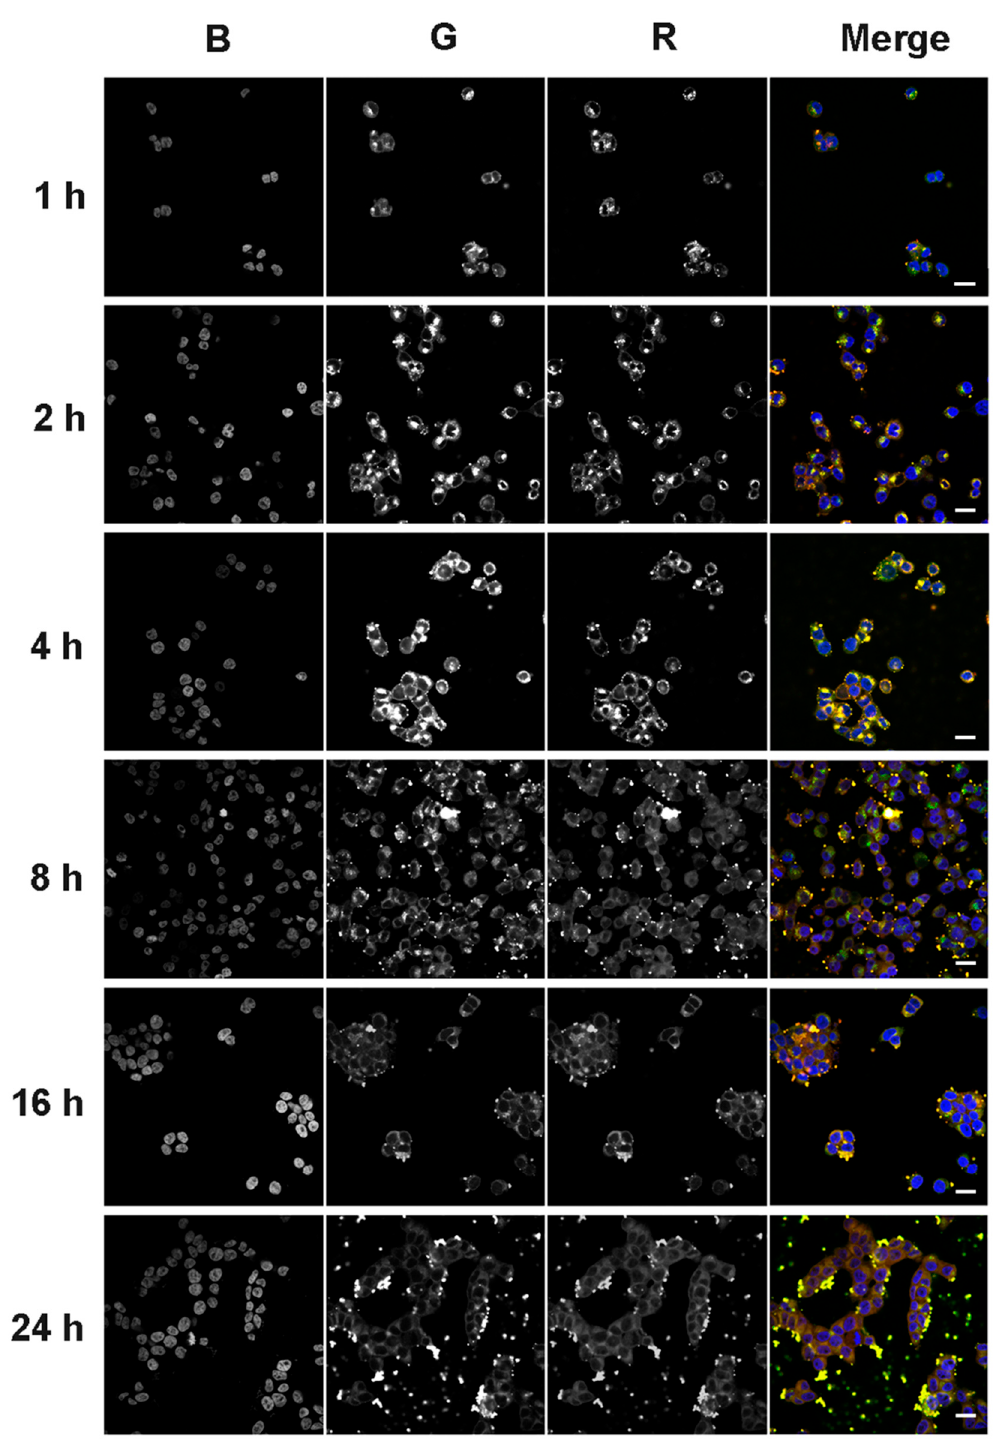
Figure 8. Accumulation of duplexes TD3 / ON-PO in KB-8-5 cells. Analysis of samples was performed 1, 2, 4, 8, 16 and 24 h after addition of duplexes (1 µ M) to the cells. Duplexes consisted of FAM-labeled TD3 and By5.5-labeled ON-PO. Analysis was performed with confocal fluorescent microscopy by using a plan-apochromat 63 × / 1.40 Oil DIC M27 objective. Three-channel (BGR) pictures were obtained using staining by DAPI (nuclei staining) ( B ); FAM ( G ), attached to TD3, and By5.5 ( R ), attached to ON-PO. Scale bars: 20 µm.